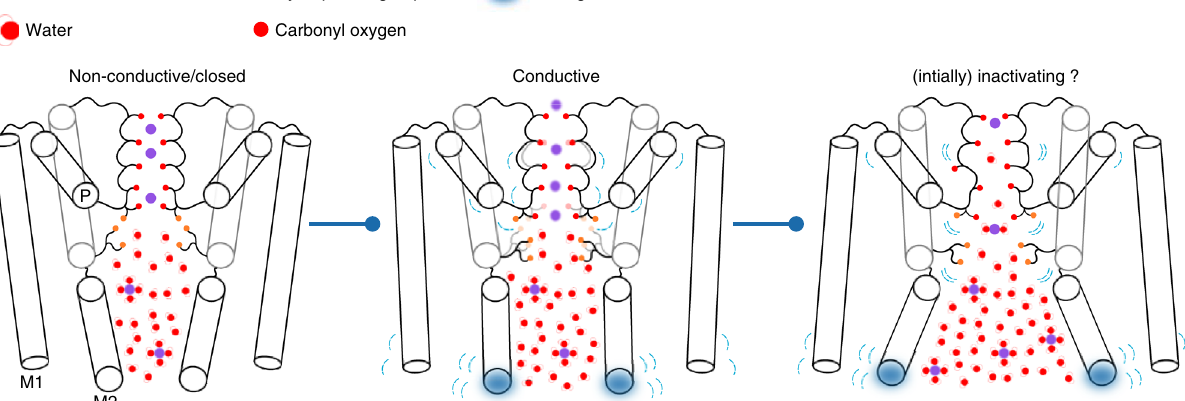
Fig. 6 Schematic of a SF-activated potassium channel gating. For small openings of the AG, the channel is in a low-conductive (closed) conformation, even if its cavity can be hydrated and is accessible to K + ions. This effect is a consequence of the barriers for ion permeation imposed by the SF, especially at the S4 ion binding site. The position of the S4 threonine (T59 in MthK) is stabilized by hydrophobic contacts with residues from the M2 helix (I84 in MthK). When a gating stimulus (e.g. voltage or ligand binding) causes the AG to open, the collective motion of M1 and M2 helices and the hydrophobic contacts force the S4 threonine to widen the SF, lowering the barriers and thus allowing for K + fl ow through the channel. For larger levels of the AG opening, the SF at S4 widens to a point where water molecules can frequently enter the ion binding sites, leading to current decline and carbonyl fl ipping, which, we speculate, is related to the channel ’ s